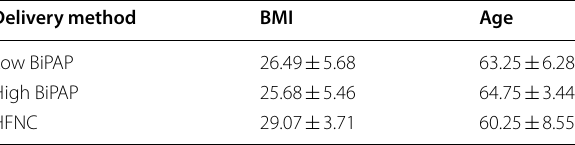
Table 1 Body Mass Index (BMI) (kg/m 2 ) and age (years) of the patients who participated in the study ( n expressed as mean SD ±